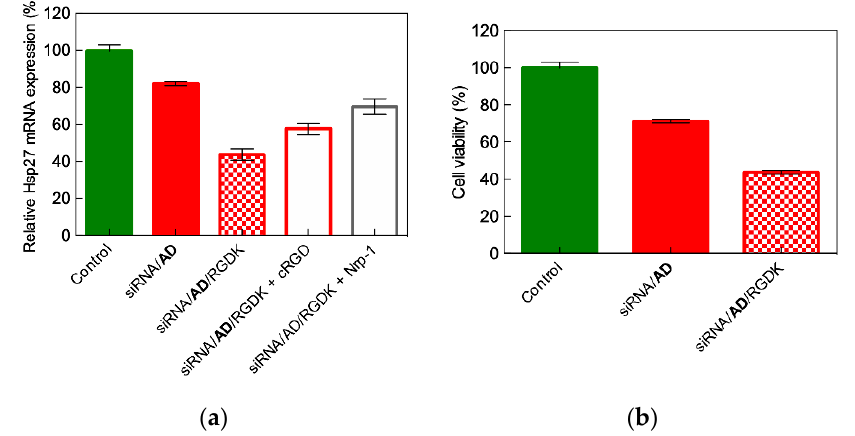
Figure 16. ( a ) mRNA levels following knockdown of Hsp27 in PC-3 cells with siRNA/ AD and siRNA/ AD /E 16 G 6 RGDK nanoparticles. The last two columns show the results of the same experiments performed in the presence of the integrin binder c-RGD and of the mAb directed toward the Nrp-1 receptor, respectively. ( b ) Comparison of the antiproliferative activity exerted on PC-3 cells by siRNA/ AD and siRNA/ AD /E 16 G 6 RGDK nanoparticles. In both panels, non-treated cells were used for control, siRNA concentration = 20 nM, siRNA / AD N / P = 10, and AD / E 16 G 6 RGDK molar ratio = 5. Adapted from [8] with permission of the American Chemical Society, 2018.